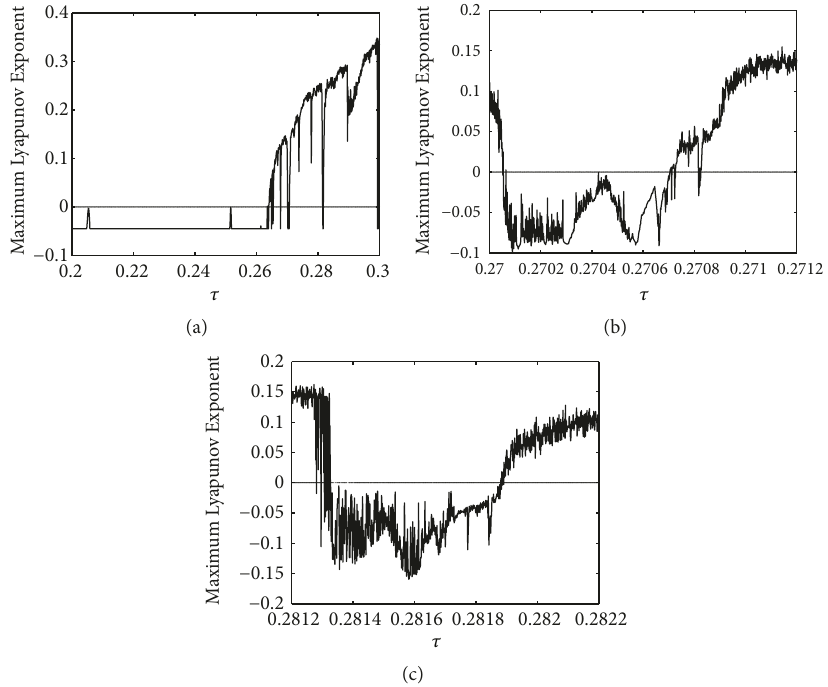
Figure 2: Diagrams of maximum Lyapunov exponent corresponding to the three graphs of Figure